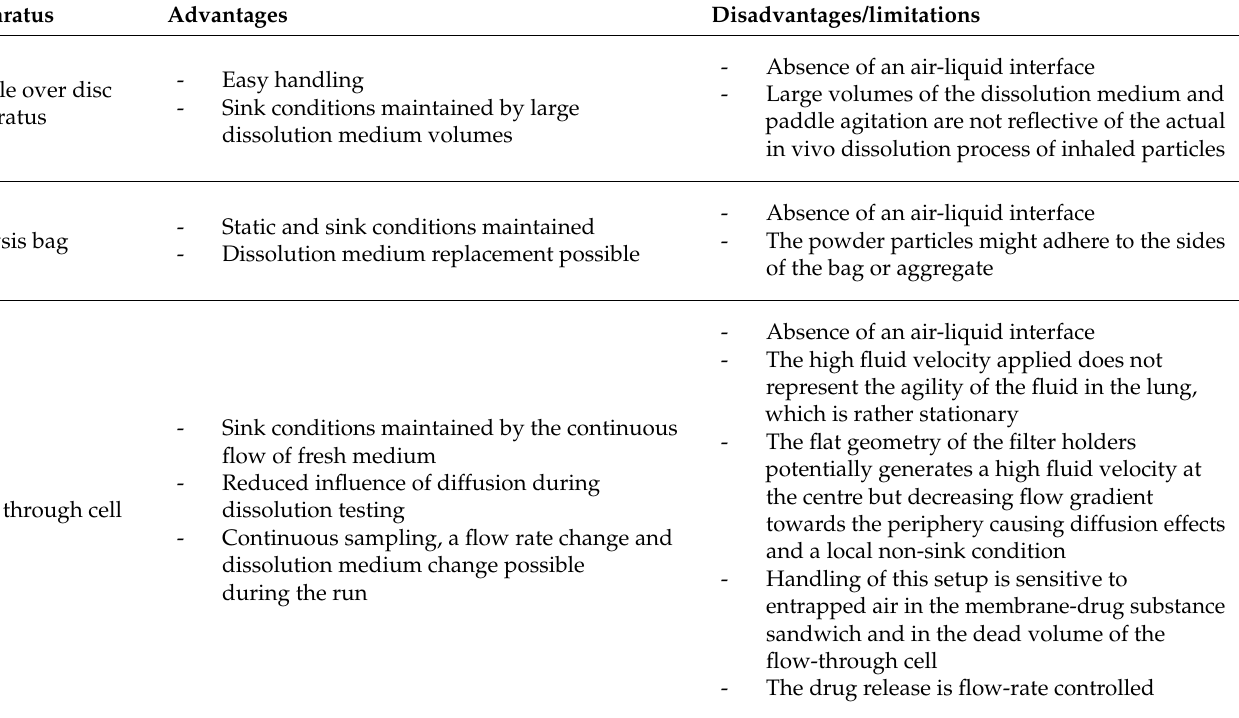
Table 3. Advantages and disadvantages/limitations of the apparatus used to evaluate the dissolution behaviour of the inhaled products. Reproduced with permissions from Eedara et al., 2019 [58],